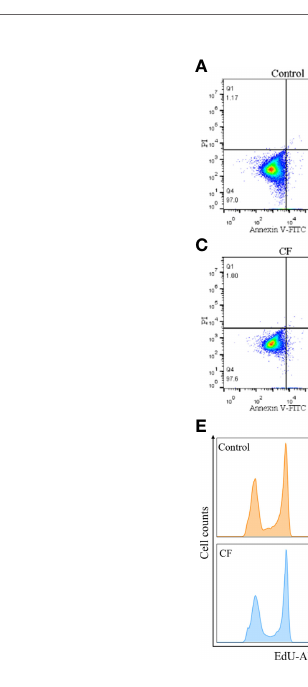
FIGURE 1 | H. pylori or HPCF inhibit proliferation and induce apoptosis in GES-1 cells. Representative apoptosis photographs of GES-1 cells treated with normal cell culture medium (A) , H. pylori (B) , CF (C) , or HPCF (D) for 24 h using fl ow cytometry. The EdU-Alexa Fluor 488 cell count of GES-1 cells treated with these factors was detected by fl ow cytometry too (E) . Quantitative analysis of apoptosis (Q2 + Q3) (F) and proliferation (G) of GES-1 cells treated with H. pylori , CF, or HPCF was performed. The asterisks indicate signi fi cant differences from the control. n = 3. * p <0.05, ** p <0.01, *** p <0.001, **** p